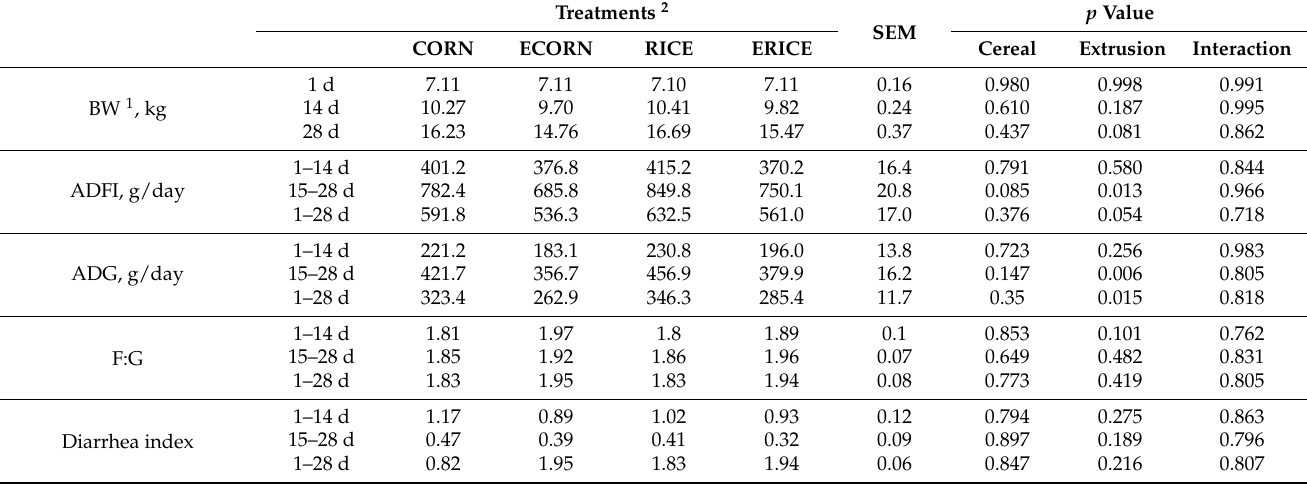
Table 3. Effects of cereal types and extrusion processing on growth performance and diarrhea index of weaned